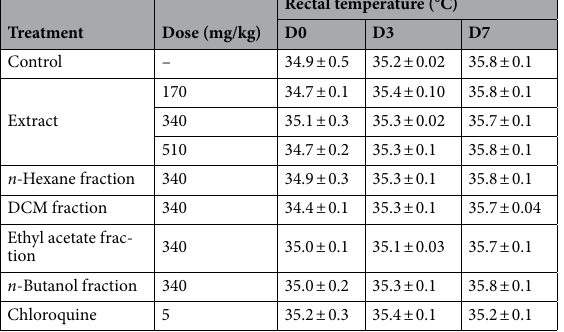
Table 5. Effect of leaf extract and fractions of S. officinarum on rectal temperatures of mice infected with P. berghei during established infection. Values are expressed as mean ± SEM, n = 6.